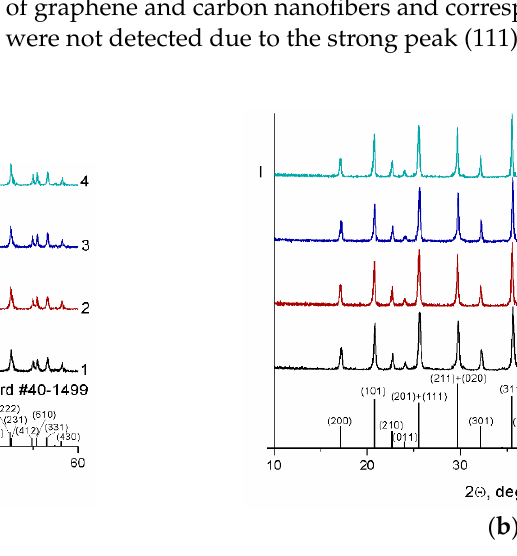
Figure 1. X-ray diffraction patterns of composites based on lithium iron phosphate and carbon nanomaterials: LFP/C Sucr /CNF (1), LFP/C Sucr /CNP (2), LFP/C PVDF /CNF (3), LFP/C PVDF /CNP (4), LFP/C Sucr /CNF bm (5), LFP/C Sucr /CNP bm (6), LFP/C PVDF /CNF bm (7), and LFP/C PVDF /CNP bm (8). The LFP precursor and carbon nanomaterials were processed in an agate mortar ( a ) and in a planetary mill ( b